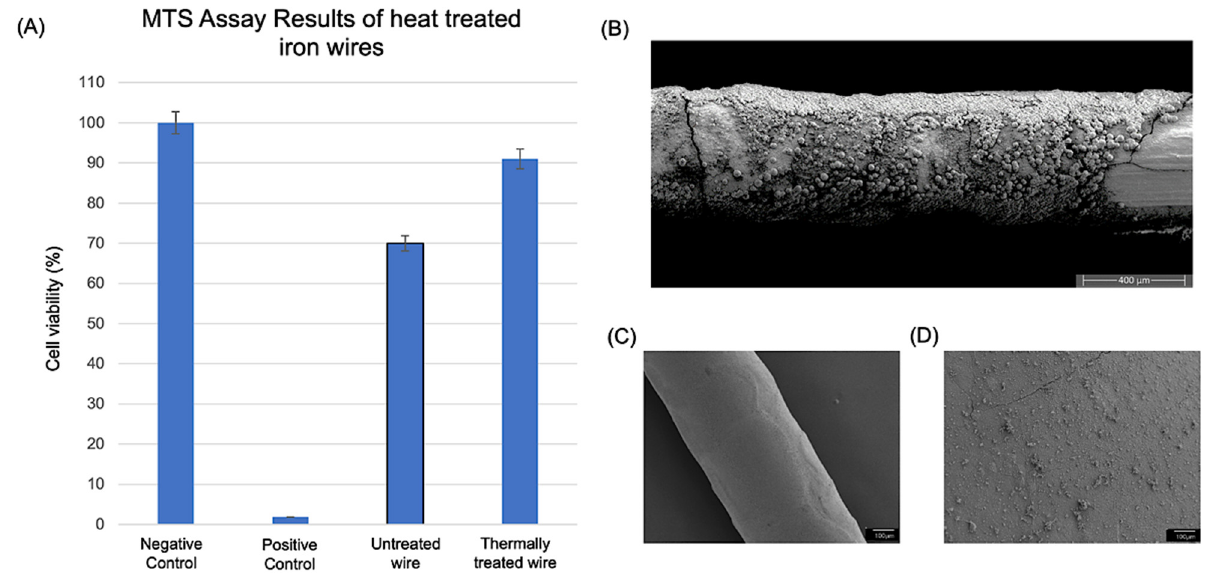
Figure 8. Cytotoxicity and hemocompatibility study results: ( A ) cell viability comparison study results of the thermally treated iron wires using MTS assay, ( B ) a representative scanning electron microscopy (SEM) image of the thermally treated wire after the cell viability test, ( C ) qualitative study results with SEM (low-magnification), and ( D ) high-magnification SEM image.